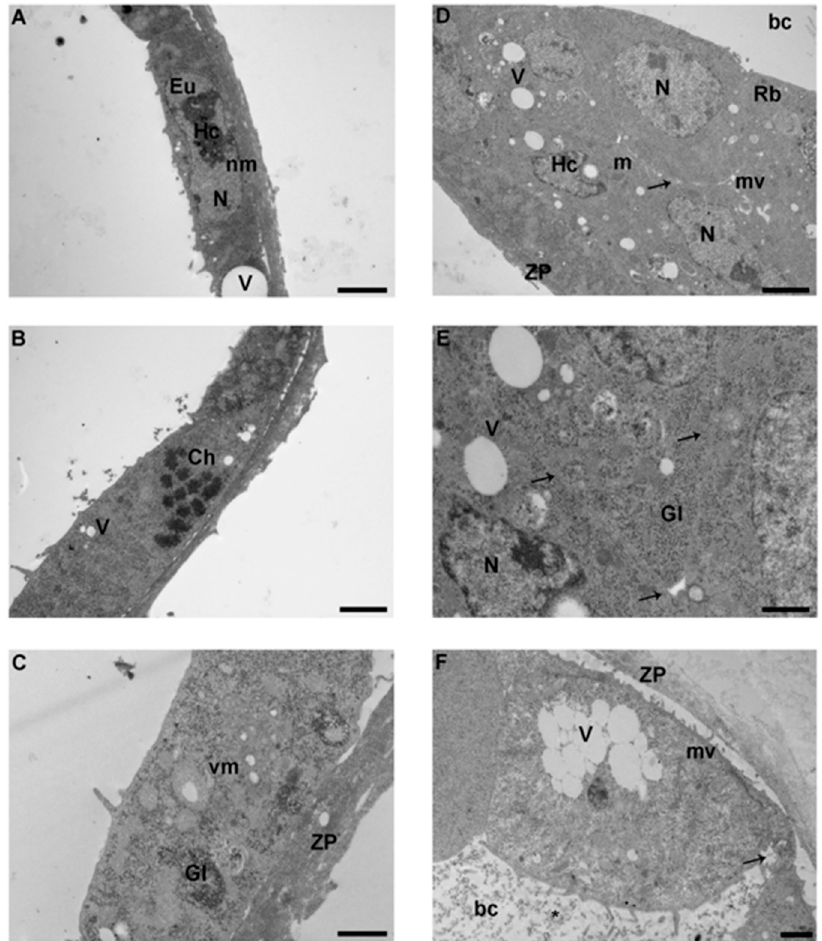
Figure 5. Ultrastructure of IVF-20% blastocyst. A. TE cells with large nuclei (N) and vacuoles (V). (TEM. Bar: 2 µ m). B. TE blastomere in mitotic division with evident chromosome (Ch) (TEM. Bar: 2 µ m). C. High magnification of TE blastomere showing vacuolated mitochondria and glycogen granules (TEM. Bar: 1 µ m). D. Ultrastructure of ICM cells. Nuclei (N) showing a few patches of heterochromatin (Hc) (TEM. Bar: 2 µ m). E. Intercellular contacts (arrow) between 3 ICM blastomeres (TEM. Bar: 1 µ m). F. Extremely vacuolated blastomere exhibit interruption of the cellular membrane (arrow) and numerous cellular fragments (*) in the blastocoel cavity (bc) (TEM. Bar: 1 µ m). N: nucleus; nm: nuclear membrane; Hc: heterochromatin; Eu: euchromatin; V: vacuoles; arrow: intercellular contacts; m: mitochondria; vm: vacuolated mitochondria; V: vacuoles; mv: microvilli; Gl: glycogen granules; Rb: residual bodies; ZP: zona pellucida; bc: blastocoel cavity. Table 2. Comparison of the main ultrastructural marker of quality among blastocyst groups (control vs IVF 5% and 20%). Legends: N.D.: no differences. Blastocyst Control IVF 20% Blastocyst